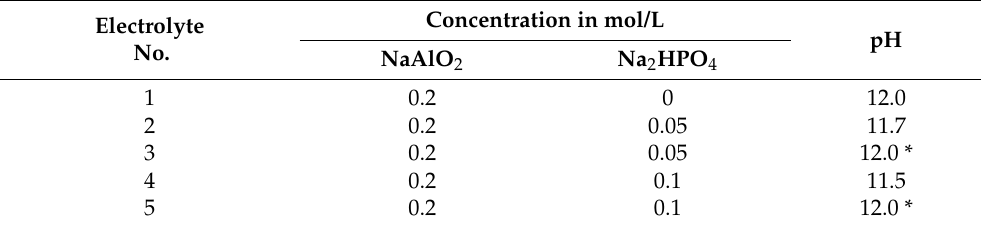
Table 1. Chemical composition and pH of the electrolyte solutions used in this study. Electrolyte